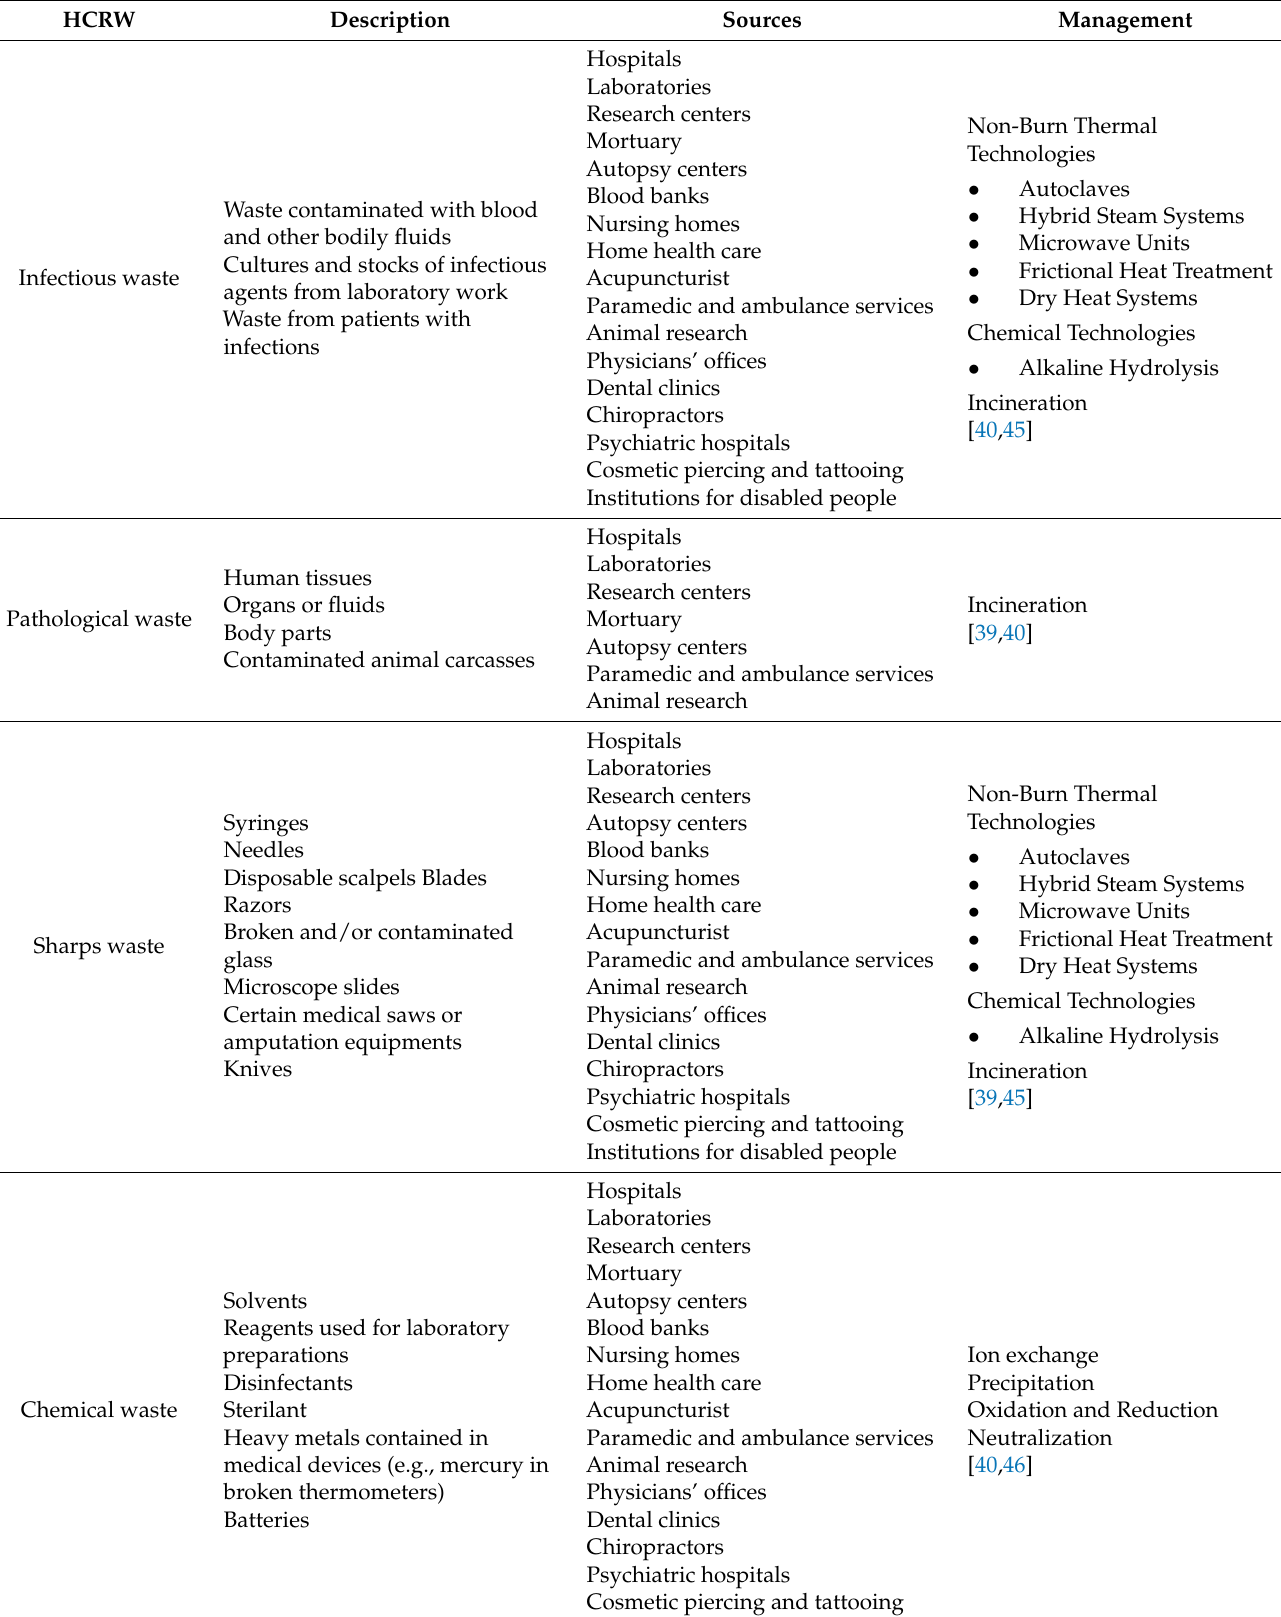
Table 1. HCRW generators and